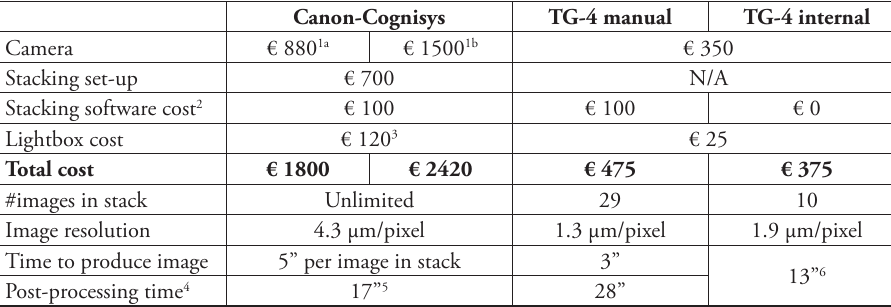
Table 1. Comparison in price (minimum prices) and processing speed of the Canon-Cognisys setup with both TG-4’s stacking modes. 1a Canon EOS 600D with 60mm EF-S f/2.8 macro lens; 1b Canon EOS 600D with 65mm MP-E f/2.8 macro lens; 2 off-camera flashes and platform; 3 price for lifetime license of Helicon Focus Lite; 4 post-processing time depends on processor type and speed among other factors; 5 data from Brecko et al. (2014), depends on #images in stack (here: 20); 6 already has stacking included in processing